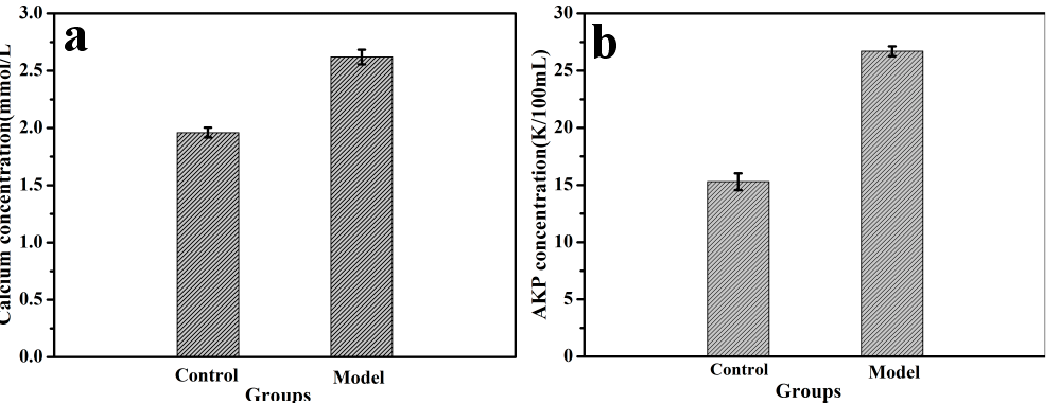
Figure 8. Calcium concentrations ( a ) and alkaline phosphatase (ALP) concentrations ( b ) in the serum of mice. Model groups and Control groups.